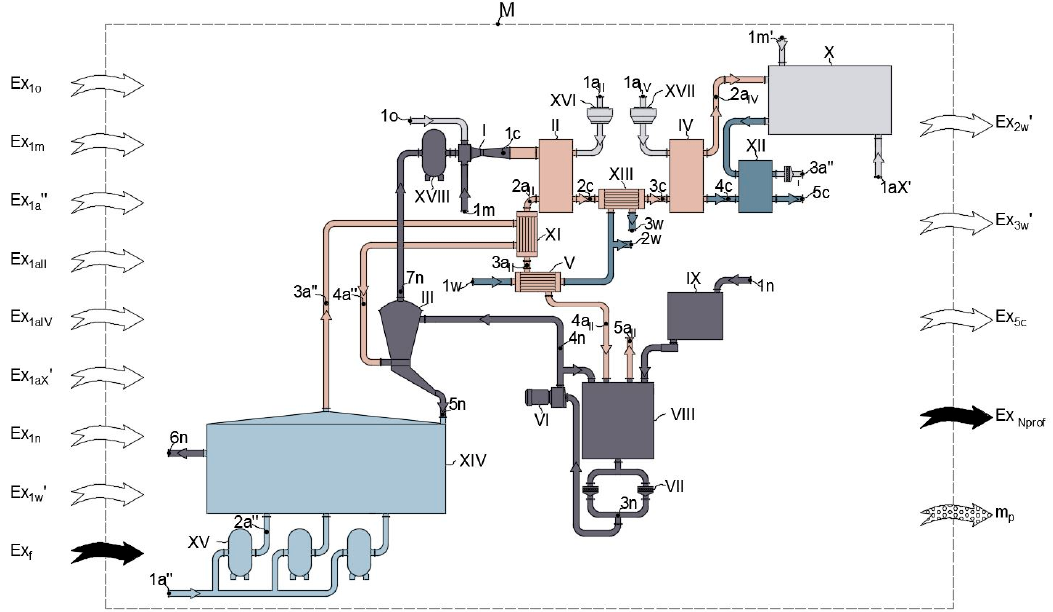
Figure 2. Considered exergy contour M of the modified technological scheme of porous ammonium nitrate granulation.